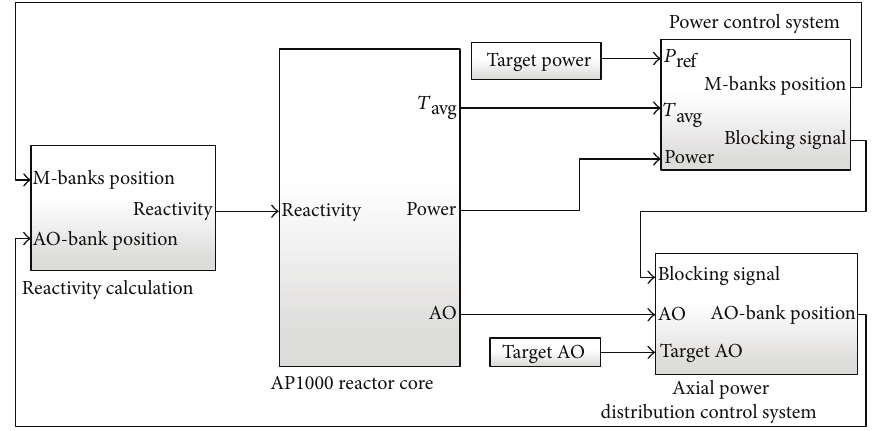
Figure 2: RCFSP, simulation platform of AP1000 in MATLAB/SIMULINK